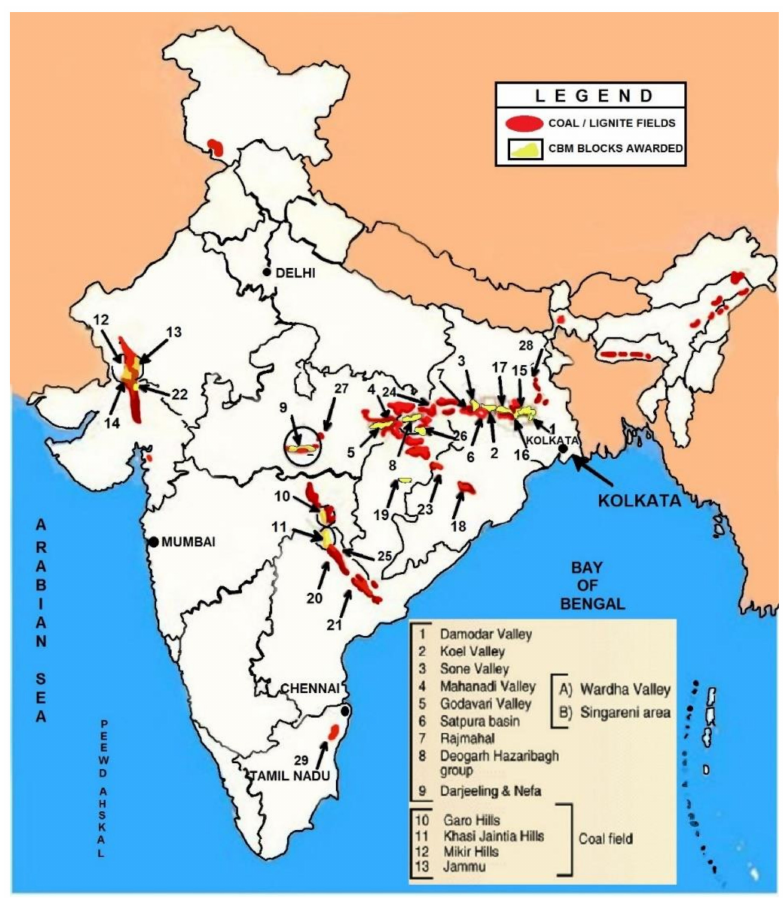
Figure 1. Classification of coalfields based on CBM potential,